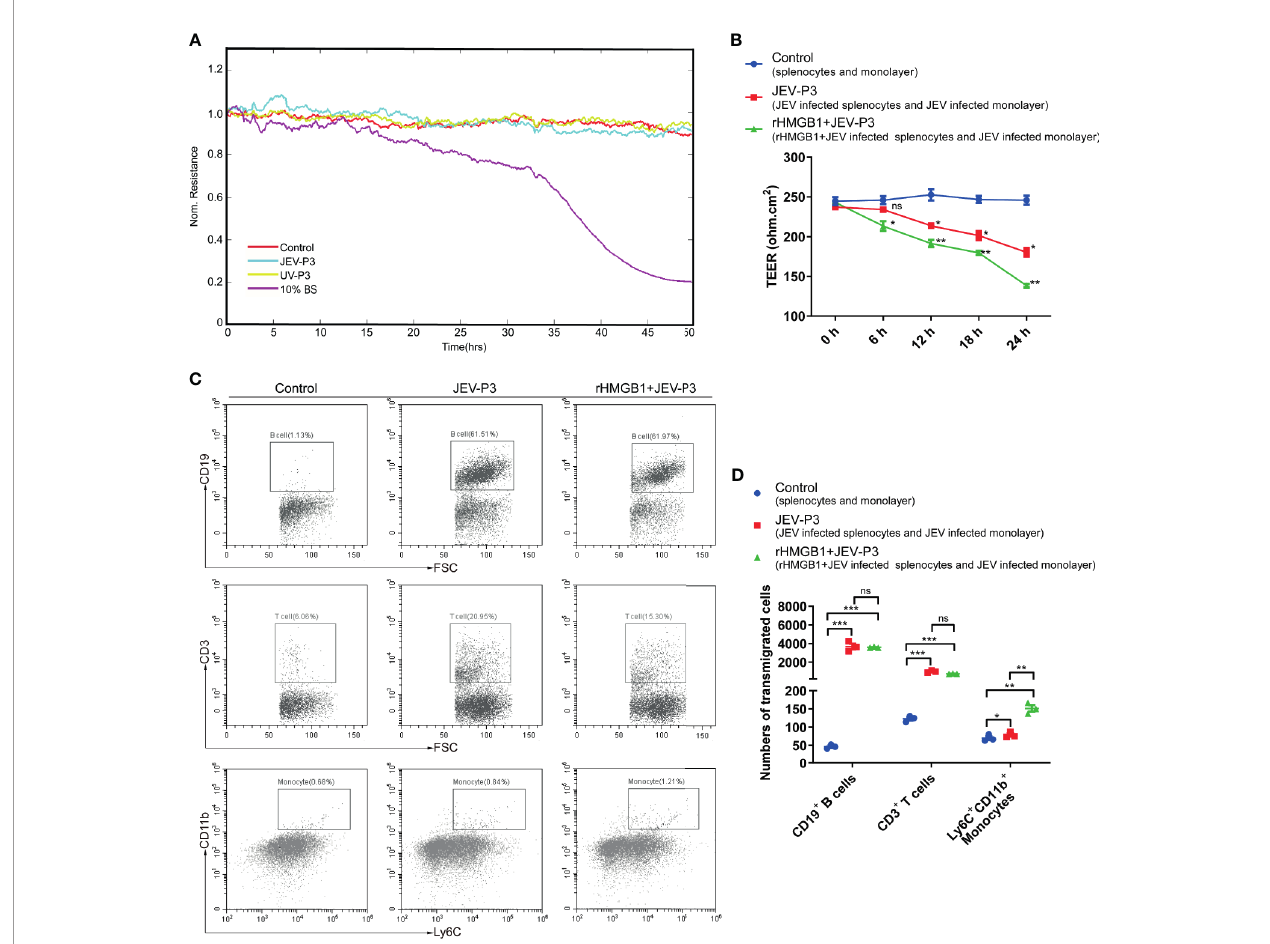
FIGURE 4 | HMGB1 facilitated immune cell transmigration during infection. (A) Real-time measurement of the JEV-P3/UV-P3 effect on the tight junction between bEnd.3 cells in vitro . The electrical resistance value represents the tight junction integrity of the bEnd.3 cells. TEER was measured at 4 kHz. bEnd.3 cells were exposed to JEV-P3, UV-P3, and 10% BS (the supernatant of JEV-infected mouse brain). Each line represents experimental repeats as measured in three wells of cells. Increased resistance is positively correlated with the barrier function of bEnd.3 cells. (B) bEnd.3 cells were cultured in the collagen-covered upper Transwell chamber in culture medium (without phenol red) for 24 h. Then, the permeability and TEER of the BMEC monolayer models were measured. Mouse splenocytes (5 × 10 5 ) were added to the upper chamber and cocultured with the monolayer for 24 h. Then, the transmigrated cells in the lower chamber were collected and counted by fl ow cytometry. The TEER value of control (splenocytes cocultured with monolayer), JEV-P3 (JEV infected splenocytes cocultured with JEV infected monolayer) and rHMGB1+JEV-P3 (rHMGB1 was added in the cocultured system of JEV infected splenocytes and JEV infected monolayer) models were measured at the indicated times (0 h, 6 h, 12 h, 18 h, and 24 h). (C) After splenocytes were cocultured with the bEnd.3 cell monolayer for 24 h, the transmigrated cells (obtained from the lower chamber), including CD19 + B cells, CD3 + T cells, and Ly6C + CD11b + monocytes, were collected and analyzed by fl ow cytometry.